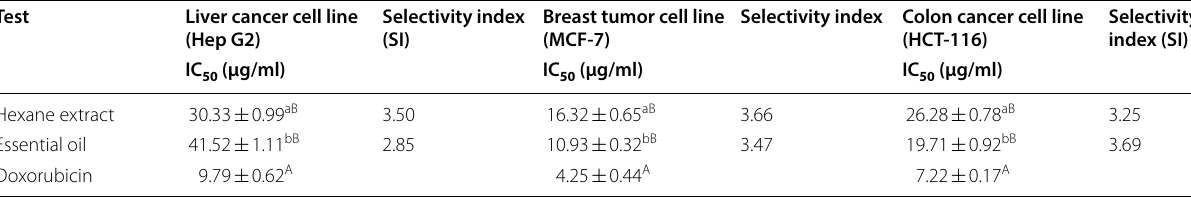
Values are SEM (n 3), means followed by different letters in same column denote significant difference at p < 0.05, paired- t -test. Lowercase letters compare means ± = of Myrrh hexane extract and essential oil, uppercase letters compare means of sample with the standard doxorubicin Selectivity index was calculated as the ratio of the IC 50 values on normal hamster lung fibroblasts (V79) to those in the tested cancer cell lines. SI > 3 indicates a promising activity